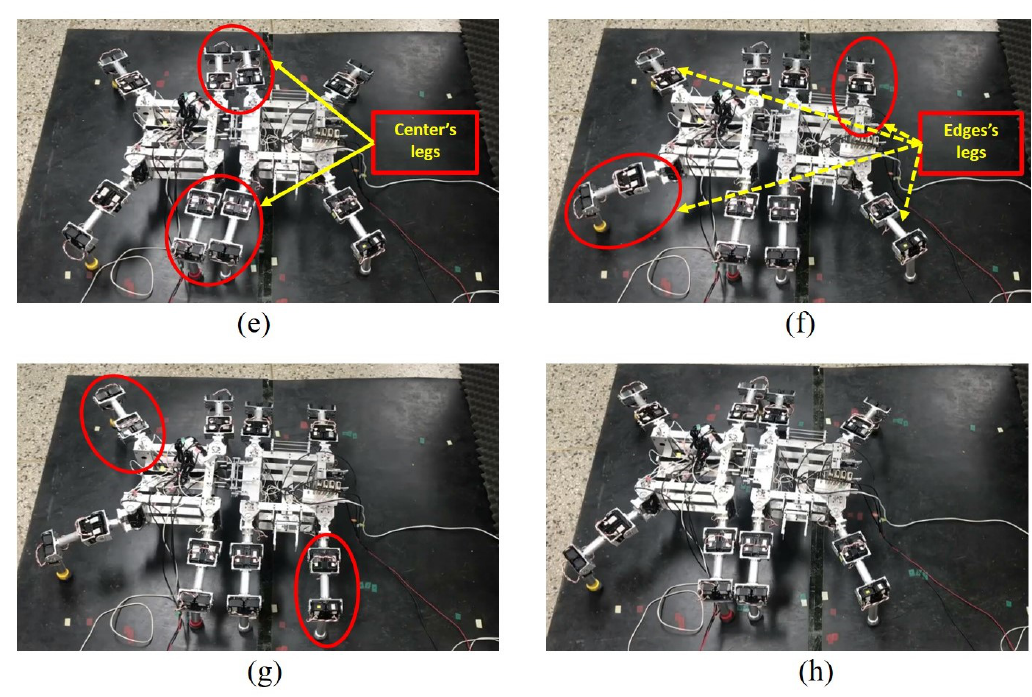
Figure 6. Combination and walking processes. ( a ) Operation begins. ( b ) Ready pose. ( c ) Robots are approaching each other. ( d ) Robots combined. ( e ) Center legs moving forward. ( f ) Front-left and hind-right legs move. ( g ) Front-right and hind-left legs move. ( h ) All legs actuate, and one step is